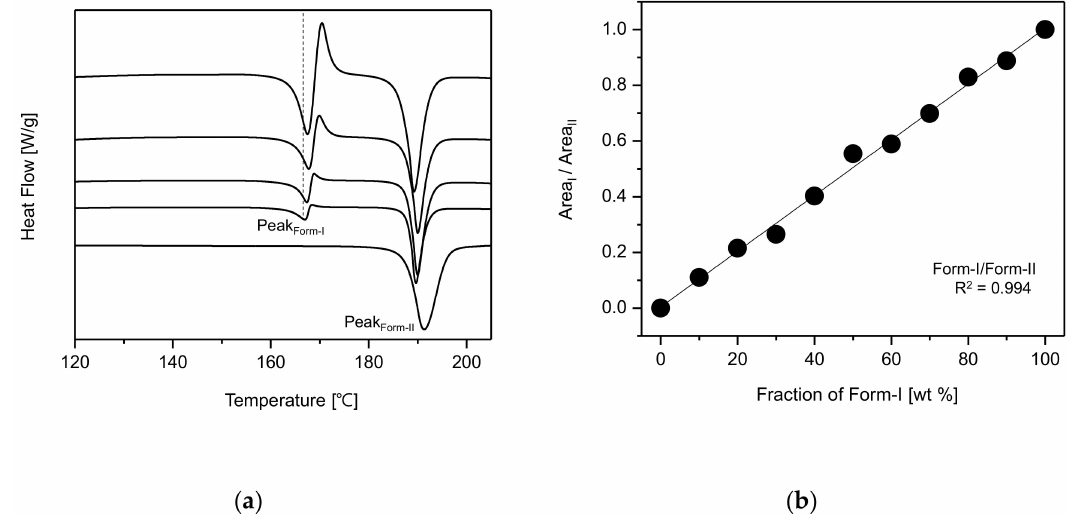
Figure 8. Evaluation of CO form-I and form-II’s polymorphic fractions based on DSC curves: ( a ) change of DSC endothermic peak depending on the polymorphic fraction variation, ( b ) CO polymorphic fraction-dependent DSC endothermic peak